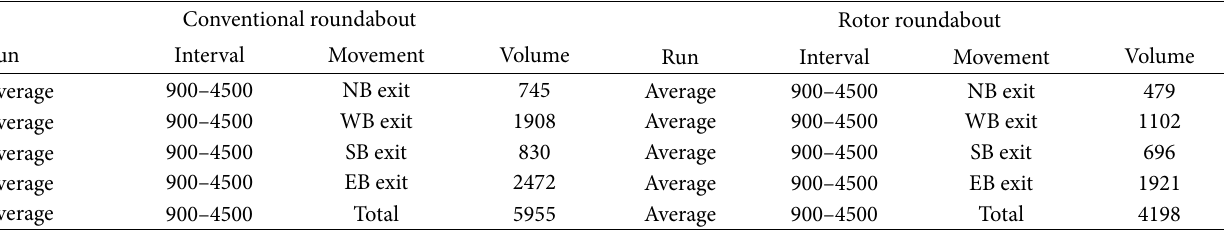
Table 10: Maximum throughput (alternative design